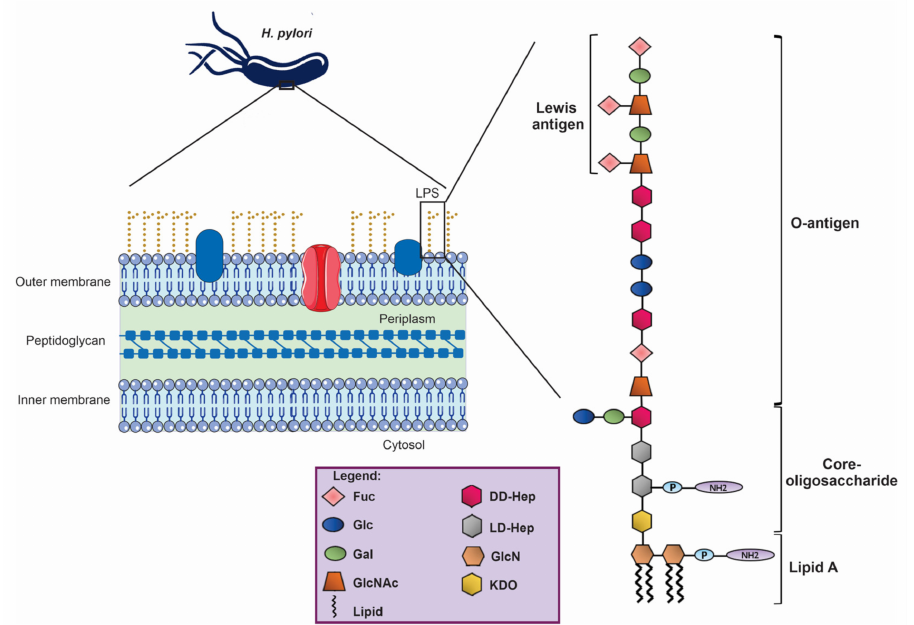
Figure 2. H. pylori LPS structure. Lacking the canonical inner and outer core organization, H. pylori LPS shows a short core and a longer O-antigen with a terminal Lewis